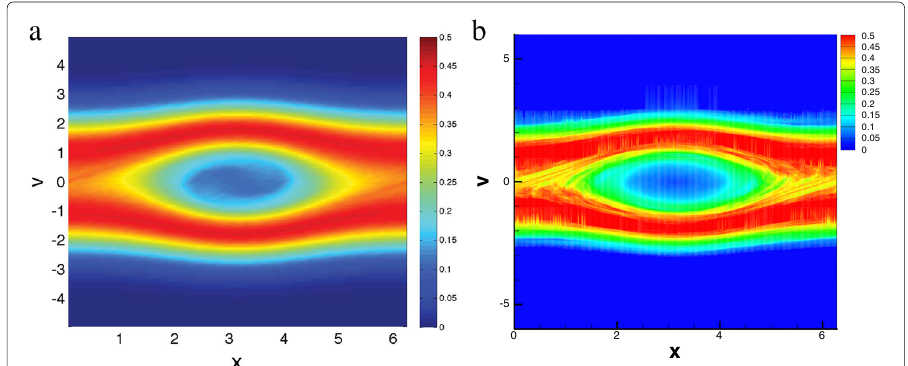
Fig. 5 Contour of the velocity distribution of the linear two stream instability at t 70. Left figure shows the WENO result and right figure shows the UGKWP solution